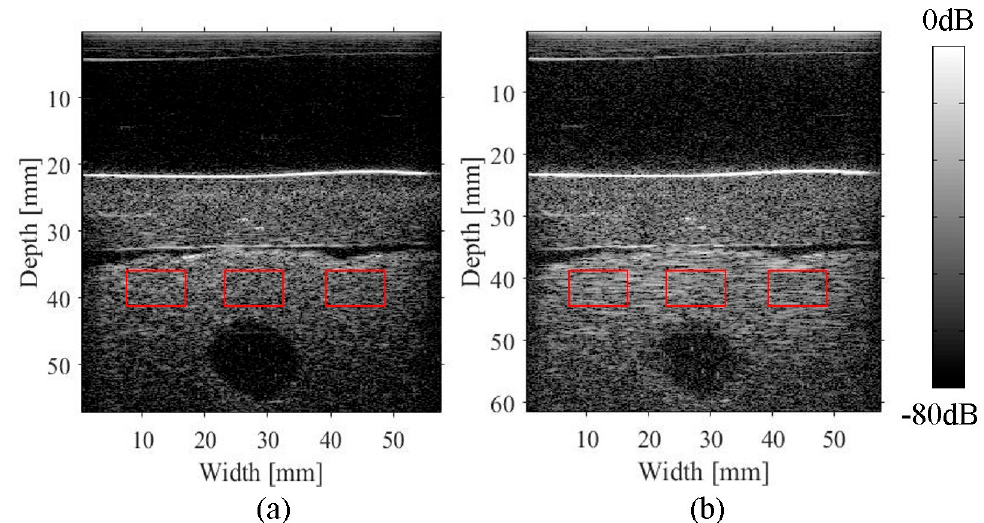
Figure 7. Comparison of B-mode images of the phantom obtained using the proposed method of compensation ( a ) and a conventional approach ( b ). The three red squares indicate ROIs for calculation of the autocorrelation function for a B-mode image. Table 6. Comparison of the half-widths of the autocorrelation functions in the lateral direction. The Half-Width of the The Half-Width of the Ratio of the Half-Width ROIs Autocorrelation Function for Autocorrelation Function for Improvement Compensated Image a Conventional Image Left square 1.35 mm